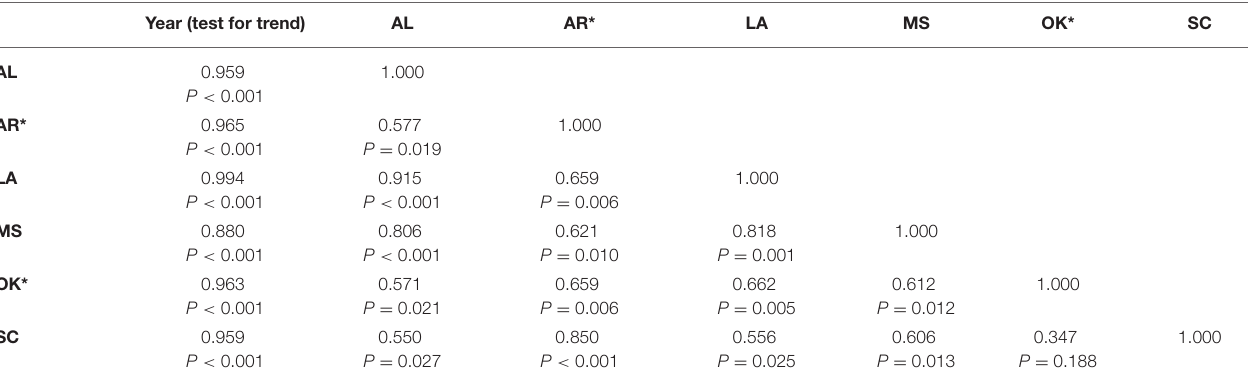
Data are from the CDC Wonder Detailed Mortality databases of the six study states: Alabama (AL), Arkansas (AR), Louisiana (LA), Mississippi (MS), Oklahoma (OK), and South Carolina (SC). * Arkansas and Oklahoma datasets did not meet criteria for stationarity using Augmented Dickey-Fuller testing (i.e., MacKinnon P-value > 0.05), after second differencing. The mortality data was not differenced in the Test for